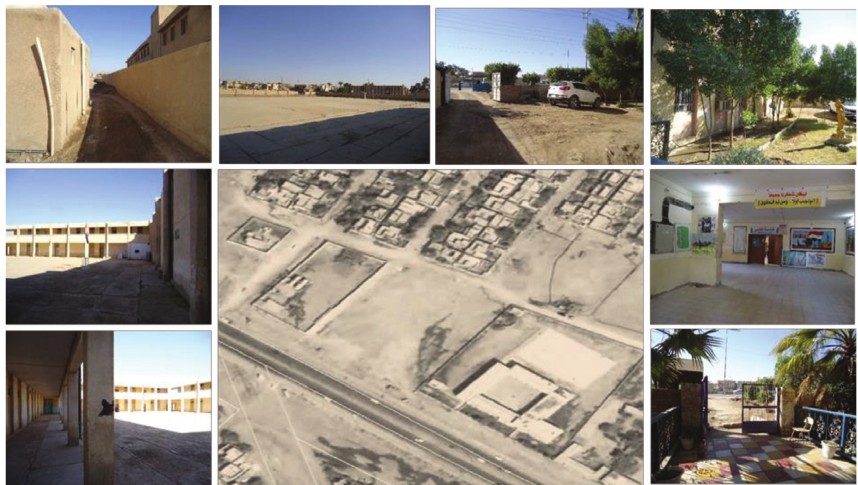
Figure 2: Description of the internal and external spaces of Al-Buhtari School for